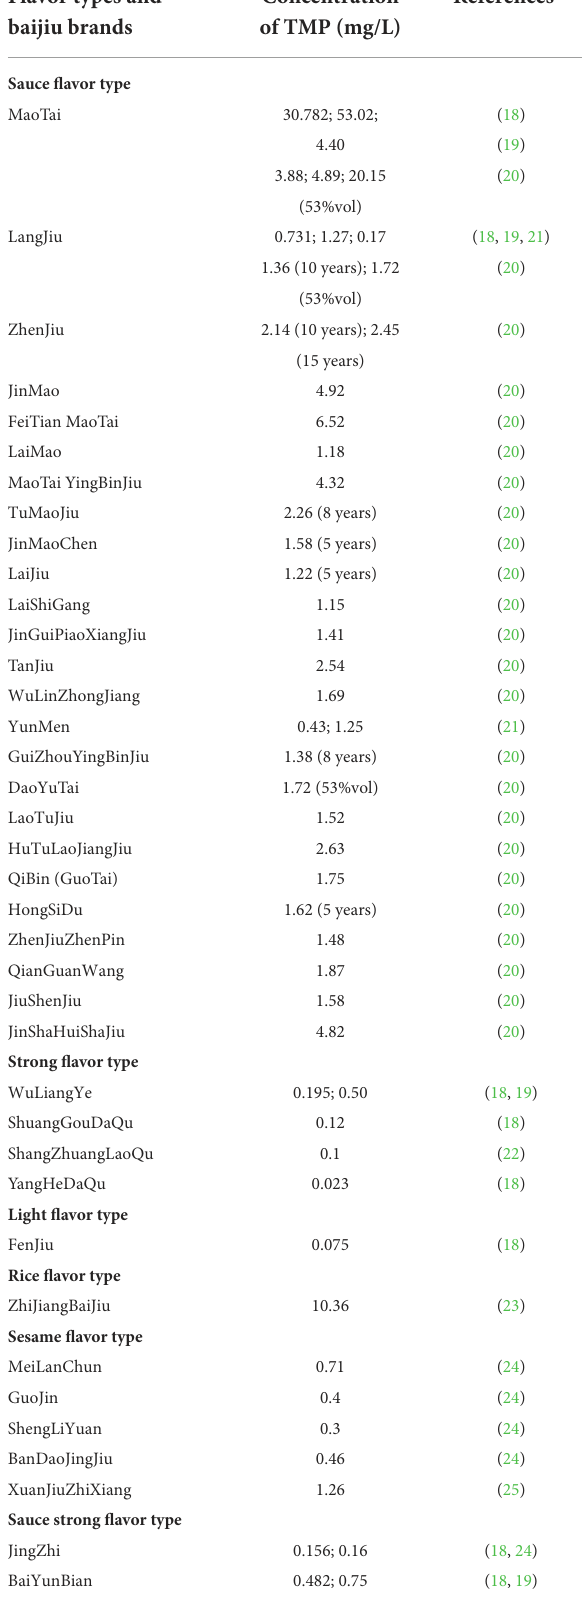
TABLE 1 Summary of TMP detected in different types of